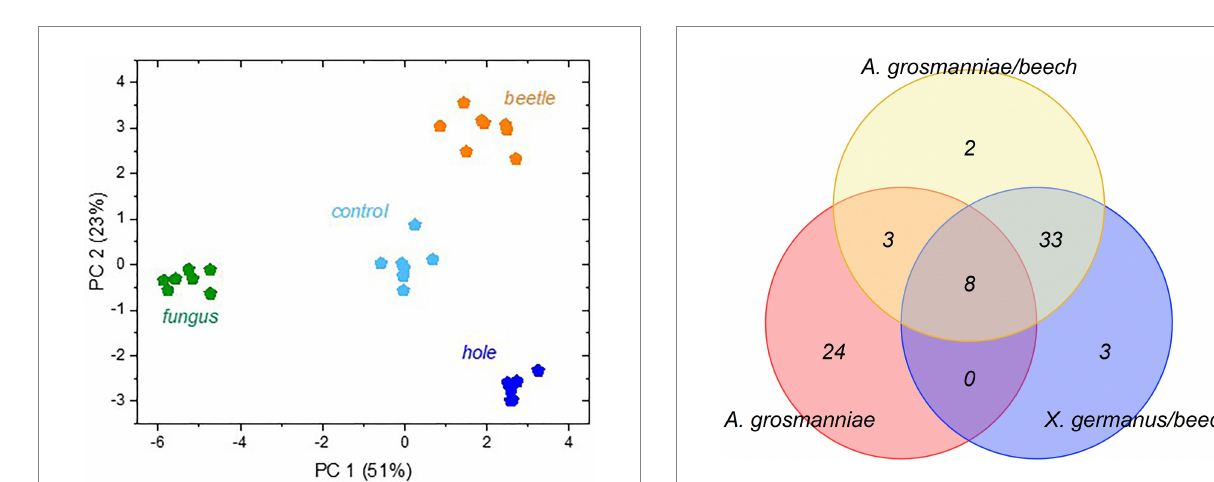
FIGURE 5 Venn Diagram indicating the volatile organic compounds commonly emitted from the different samples [i.e., beech bolts infested by X. germanus (“ X. germanus /beech”); beech bolts infected by A. grosmanniae (“ A. grosmanniae /beech”); A. grosmanniae growing in vitro (“ A. grosmanniae